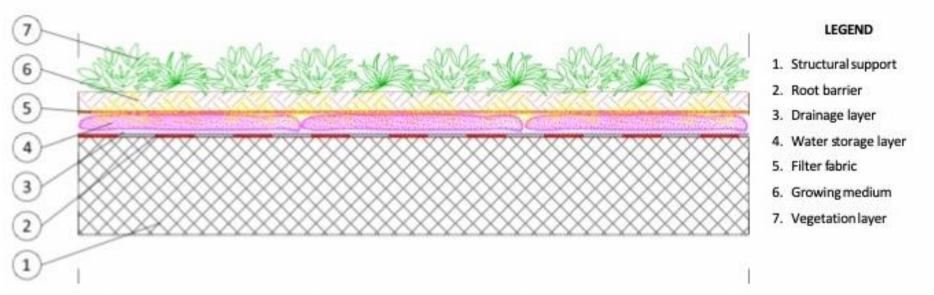
Figure 5. Sketch of the green-roof